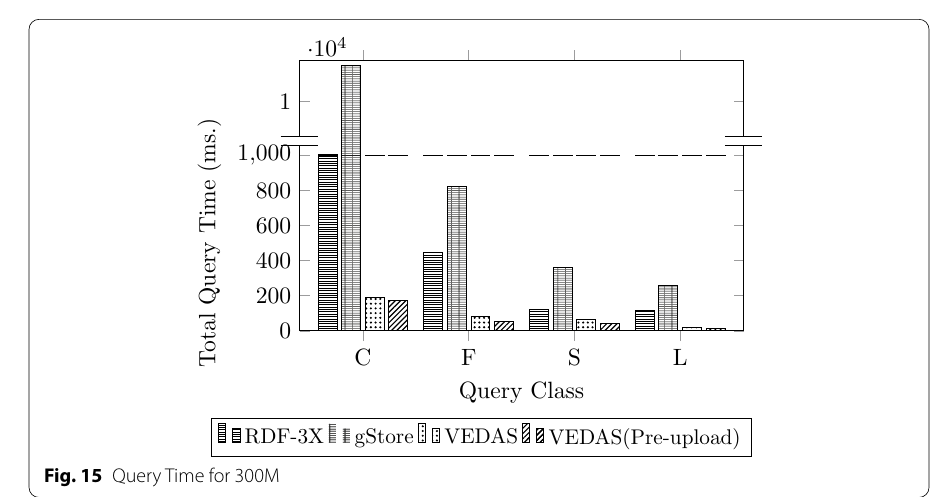
Fig. 15 Query Time for 300M